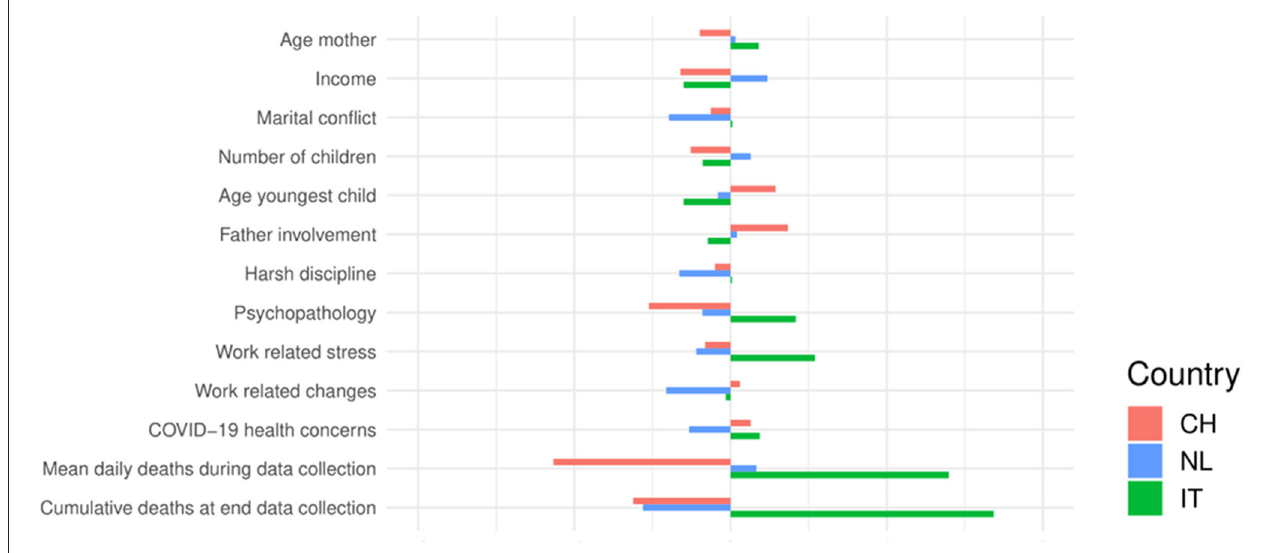
FIGURE 1 | Differences between countries on continuous sample characteristics. Differences between countries were expressed as the deviation from the grand mean in terms of